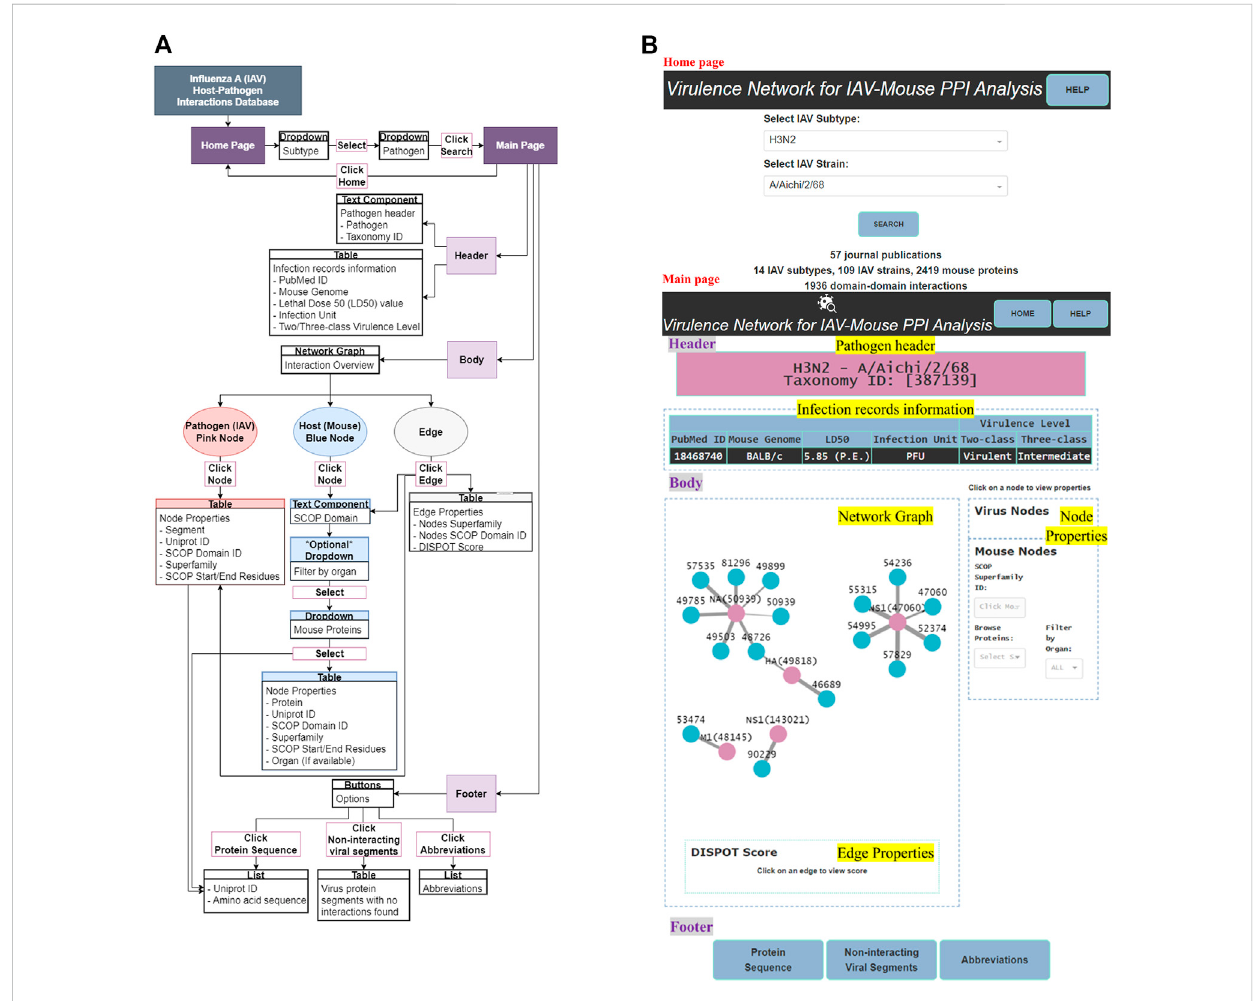
FIGURE 5 (A) GUI functionality navigation. (B) Screenshot of GUI